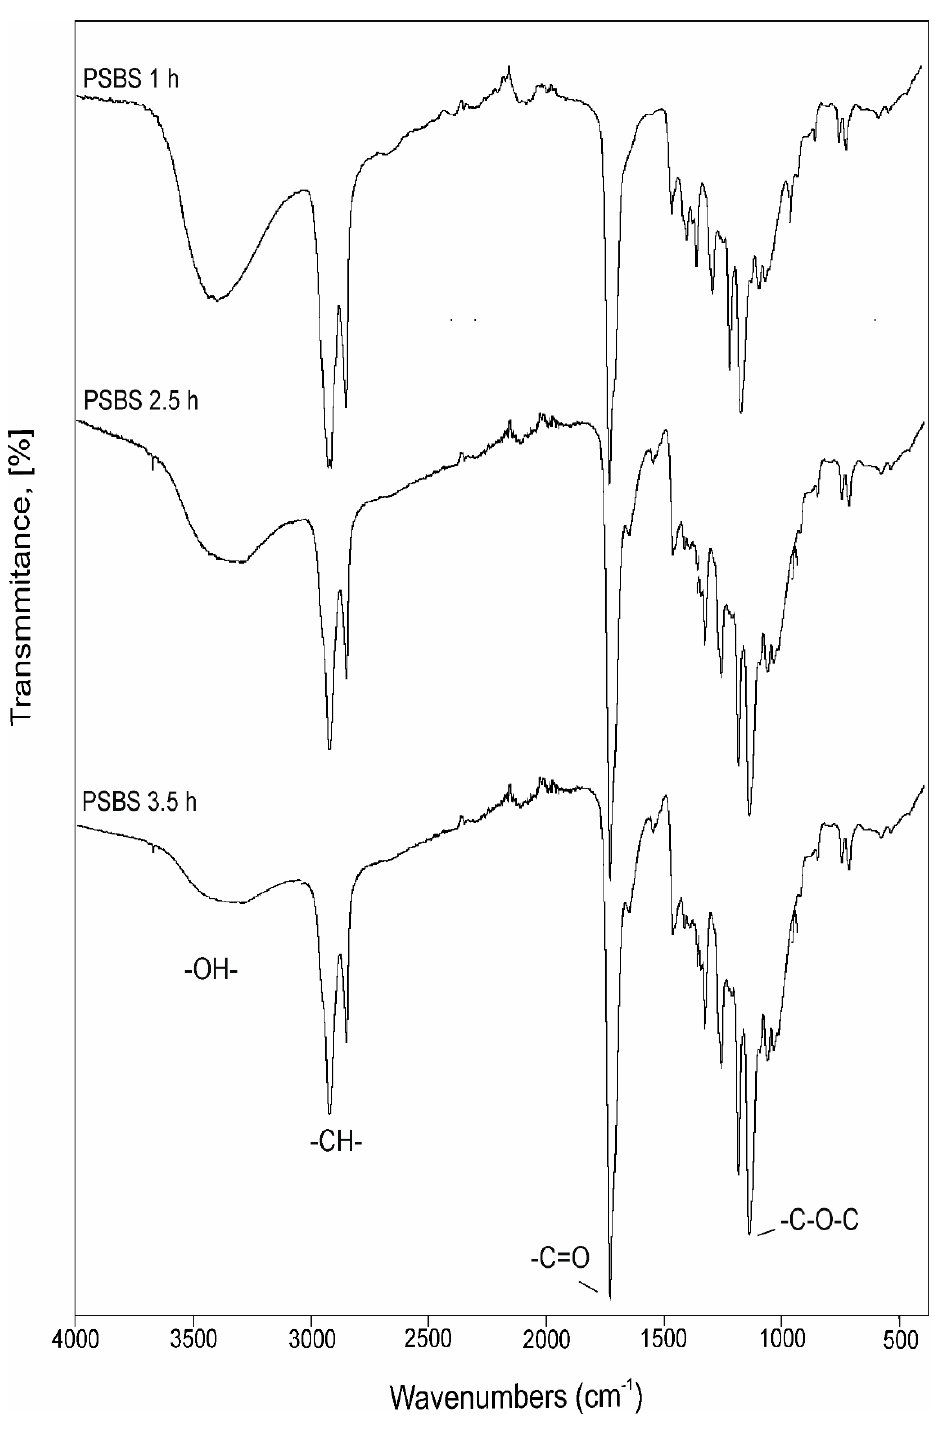
Figure 2. PSBS 1 h, PSBS 2.5 h and PSBS 3.5 h FTIR spectra.